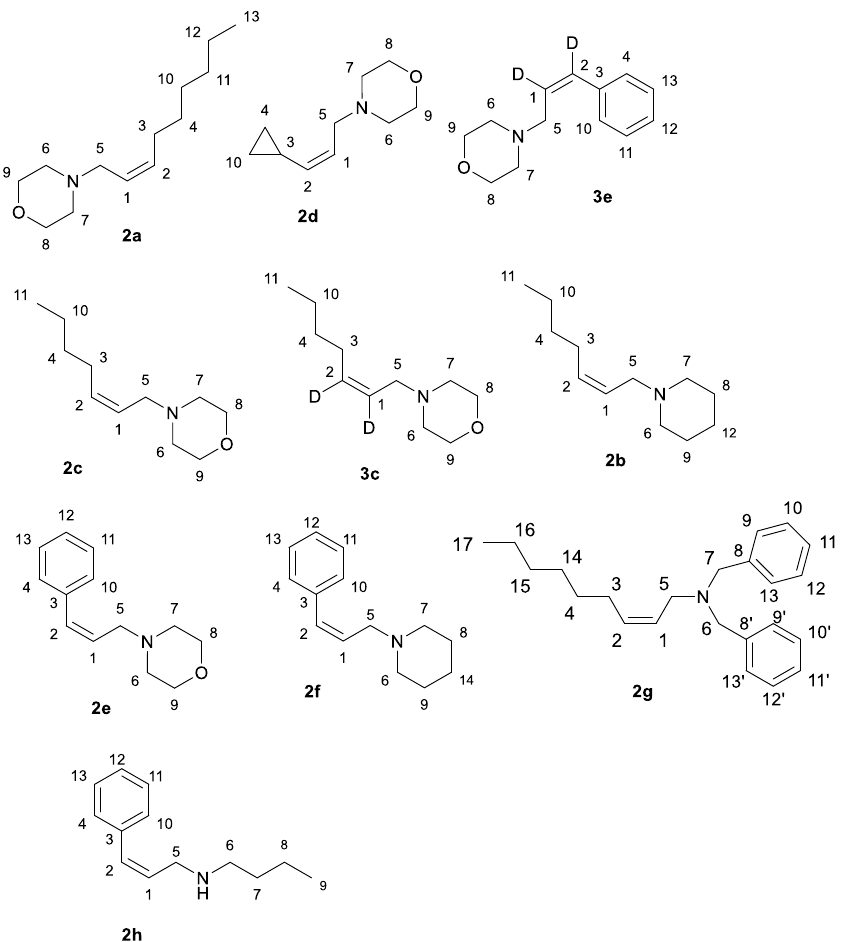
Figure 1. The numbering of atoms in the 13 C- and 1 H-NMR spectra of the compounds 2a – h , 3c , e .